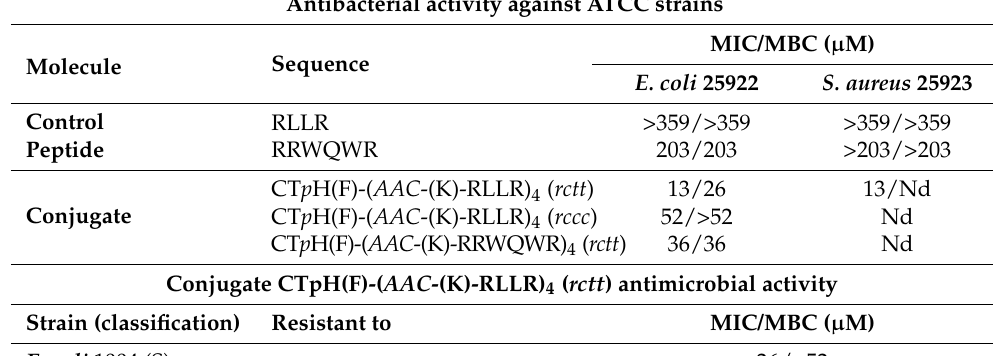
Table 2. Antimicrobial activity of tetravalent conjugates, (peptide) 4 -resorcinarene. Antibacterial activity against ATCC strains Molecule